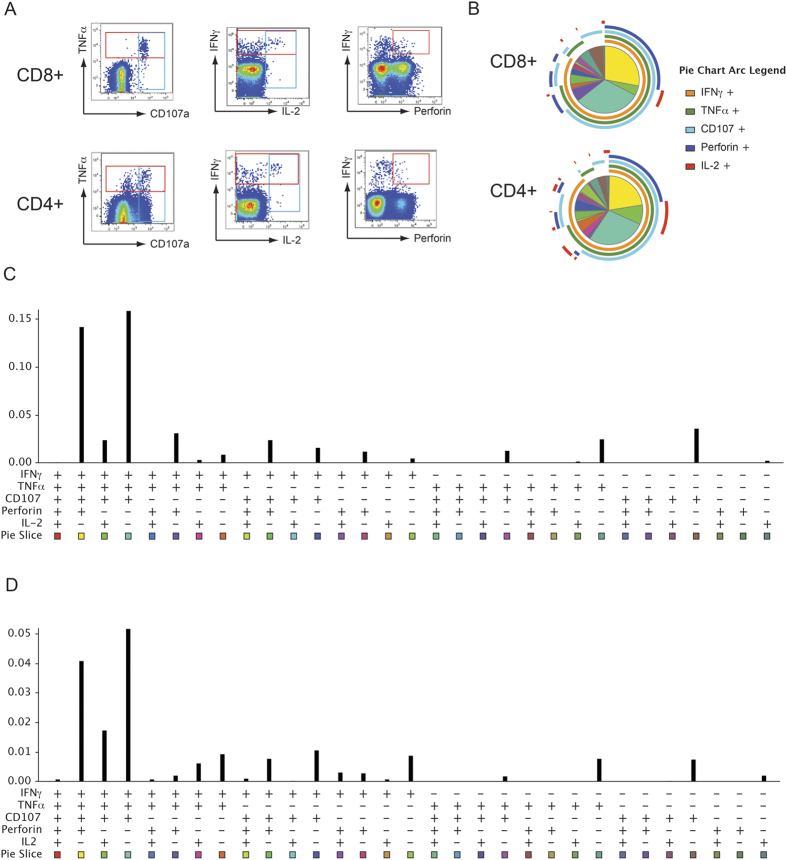
Polyfunctionality profiles of CD8 + and CD4 + CMV-specific T cells in older adults are similar.A comprehensive profile of CMV-pp65-specific T-cell function, including IL-2, TNFα, IFNγ, CD107a, and perforin, was analyzed in a cohort of older donors. (A) Representative results of flow cytometry staining of CMV-specific effector functions. The plots are obtained from a donor with moderately sized CD8 + and CD4 + responses. (B) Pie charts demonstrating the relative contribution of each of 31 possible functional subsets among the total CD8 + or CD4 + response in all participants. An accompanying bar graph depicting the average frequency of each functional subset among the CD8 + or CD4 + population is shown in Fig. 1C,D. (C,D) Frequency of each CMV-specific functional subset among CD8 + (C) or CD4 + (D) T cells in all participants. The landscapes of the functional subsets were remarkably similar between CD8 + and CD4 + cells. In both CD8 + and CD4 + T cells, the IFNγ + TNFα + CD107a + perforin + IL-2- subset and the IFNγ + TNFα + CD107a + perforin-IL-2- subset dominated the response.